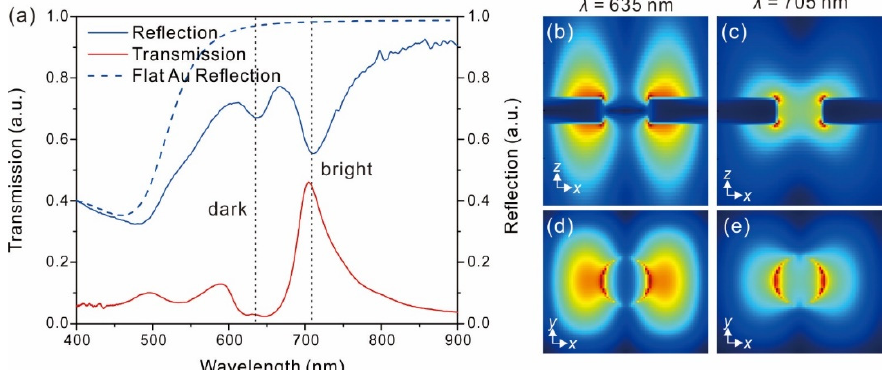
Figure 3. ( a ) Transmission and reflection of a freestanding membrane patterned with a hexagonal nanohole array which is compared with reflection of a flat Au film. Simulated electric field distributions at peak wavelengths of 635 nm and 705 nm in the x–z plane ( b , c , respectively) and at the top air/Au interface ( d , e , respectively). The array periodicity and hole diameter in the simulation are 700 nm and 200 nm, respectively.